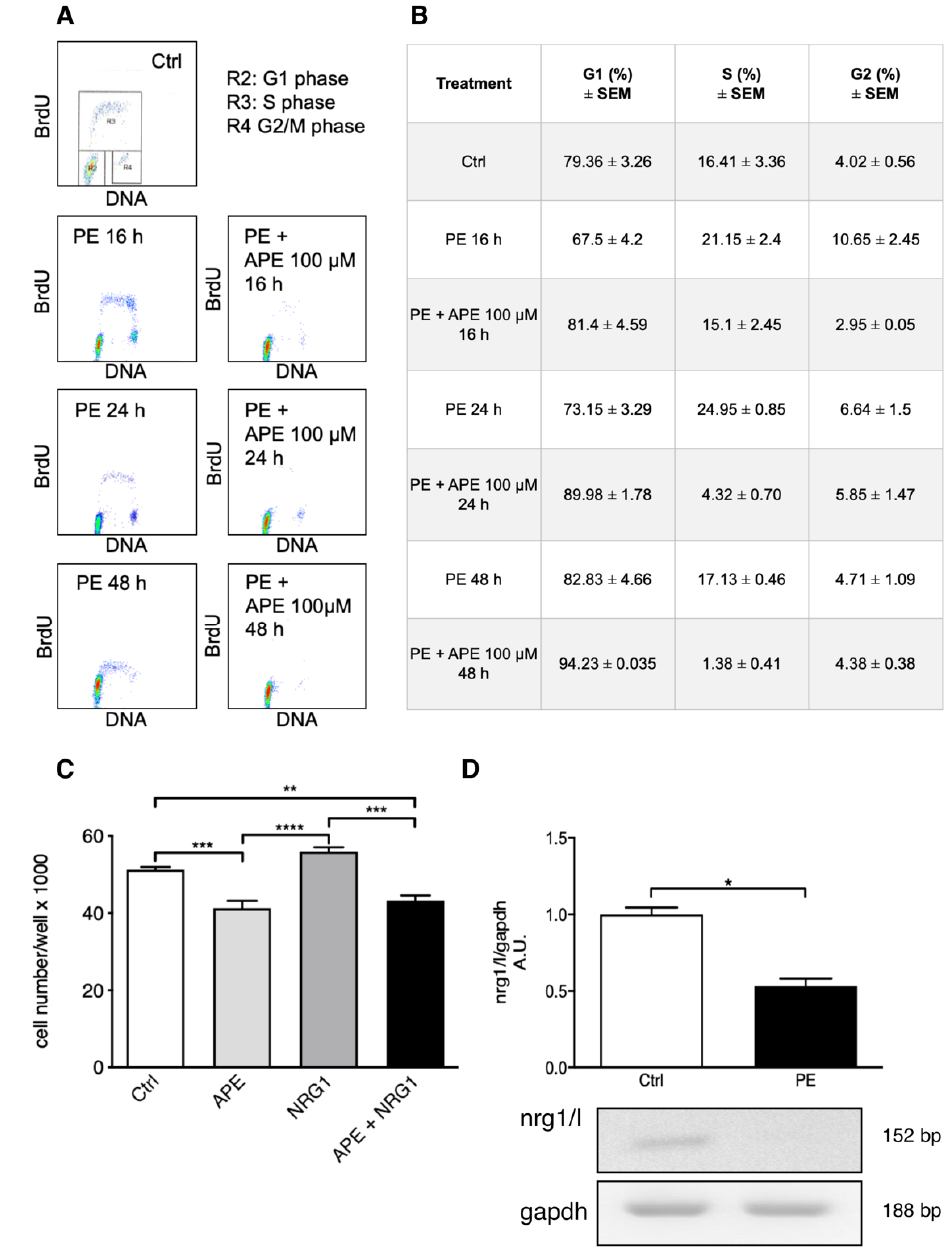
Figure 1. M2 selective stimulation counteracts SC proliferation-PE/NRG-mediated. ( A , B ) Untreated SCs present the typical proliferating profile with a percentage of cells in S phase 16.41 ± 3.36% ( n = 3). Cells treated with PE show an increase in S phase (16 h: 21.5 ± 2.4%; 24 h: 24.95 ± 0.85%; 48 h: 17.13 ± 0.46%; n = 3). APE co-treatment is able to counteract the cell proliferation PE-induced, with a strong reduction in cells in S phase (R3 region, panel A). ( B ) The percentage of S phase decreases progressively with the increase in time of APE exposure in PE treated cells (16 h: 15,1 ± 2,45%; 24 h: 4,32 ± 0.70%; 48 h: 1,38 ± 0,41%; n = 3). ( C ) MTT assay shows that 48 h of APE treatment decreases SC growth (Ctrl vs. APE, *** p < 0.001; n = 3), whereas NRG1 exposure increases cell number (APE vs. NRG1, **** p < 0.0001; n = 3). APE plus NRG1 co-treatment shows a cell growth comparable to APE treatment (NRG1 vs. APE + NRG1, *** p < 0.001; Ctrl vs. APE+NRG1, ** p < 0.01; n = 3). ( D ) Representative RT-PCR shows a significant decrease in the transcript levels of nrg1 type I in SCs after 24 h of PE treatment. Gapdh was used as housekeeping gene. The graph reports the average of the OD ± SEM of the bands normalized against the gapdh of three independent experiments (Ctrl vs. PE, * p < 0.05; n =